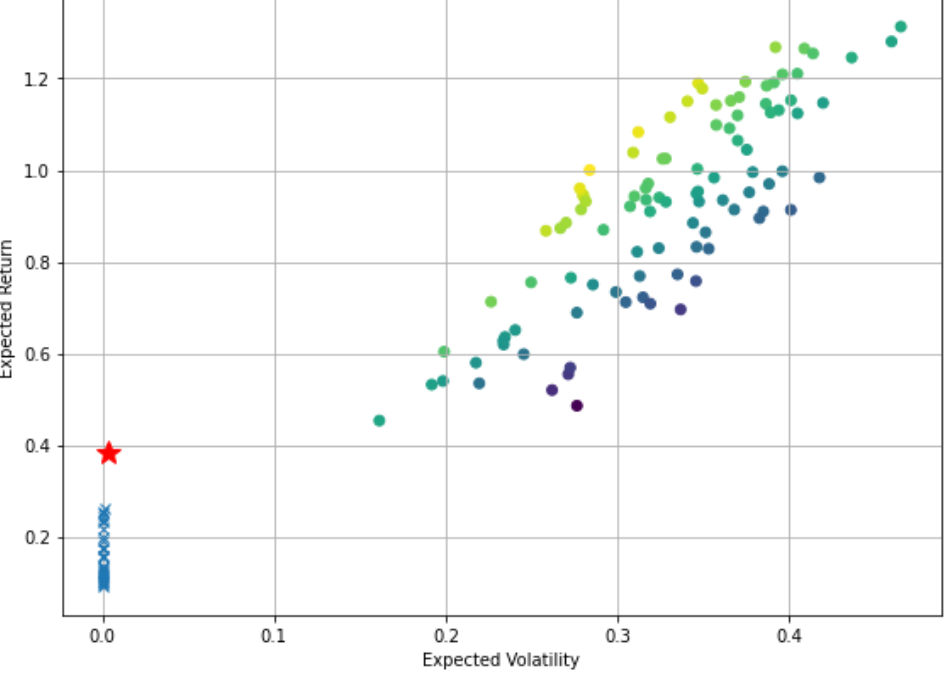
Figure 26. COVID-19 Wave II—Portfolio optimization: Expected risk and return.